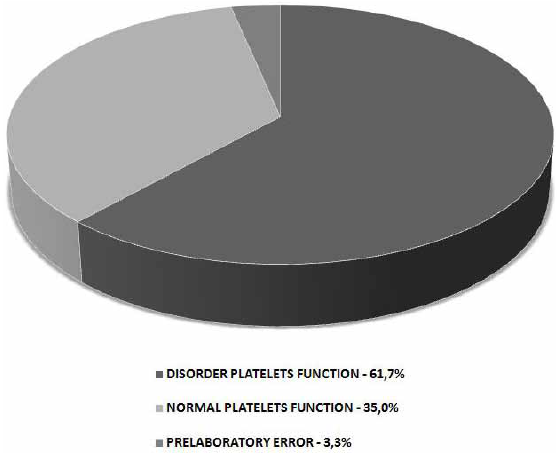
Figure 2. Graphical results of the CT test in the study